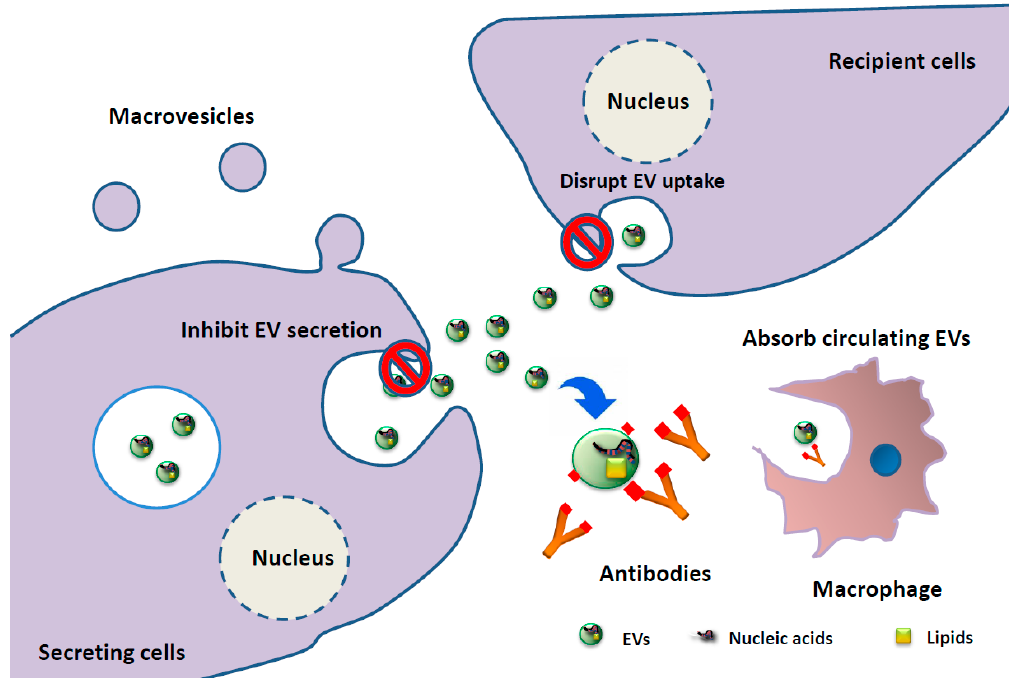
Figure 2. Strategy for extracellular vesicles (EV)-targeting therapy. Cancer-derived EVs have a crucial role in cancer development. Thus, EV elimination is potentially a new therapeutic strategy in MM. The first strategy is inhibition of EV secretion from MM cells. The second strategy is the absorption of circulating EVs. Recognition by EV-specific antibodies is followed by internalization by macrophages through phagocytosis. The third strategy is the disruption of EV uptake. These strategies have the potential to prevent cancer progression.